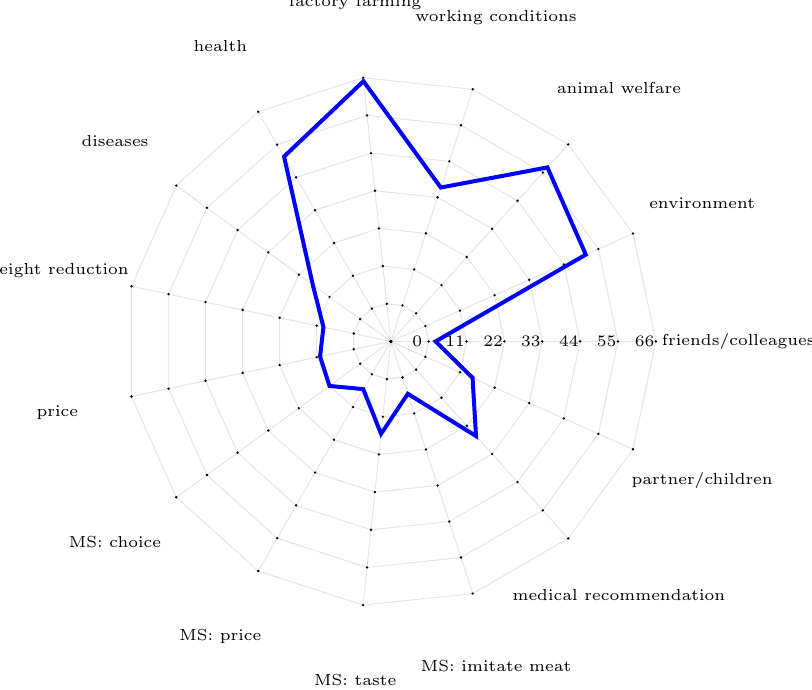
Figure 6. Radar diagram showing counts for chosen possible reasons for meat reduction. (Note: MS = Meat substitutes. MS: choice = More choice of MS, MS: price = cheaper MS, MS: taste = tastier MS, MS: imitate meat = MS which imitate meat